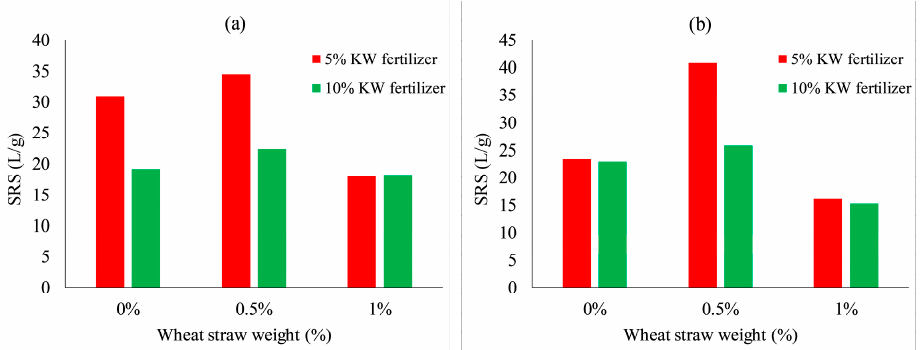
Figure 20. Scouring resistance of VC relative to wheat straw content: ( a ) Ryegrass ; ( b ) Festuca elata .